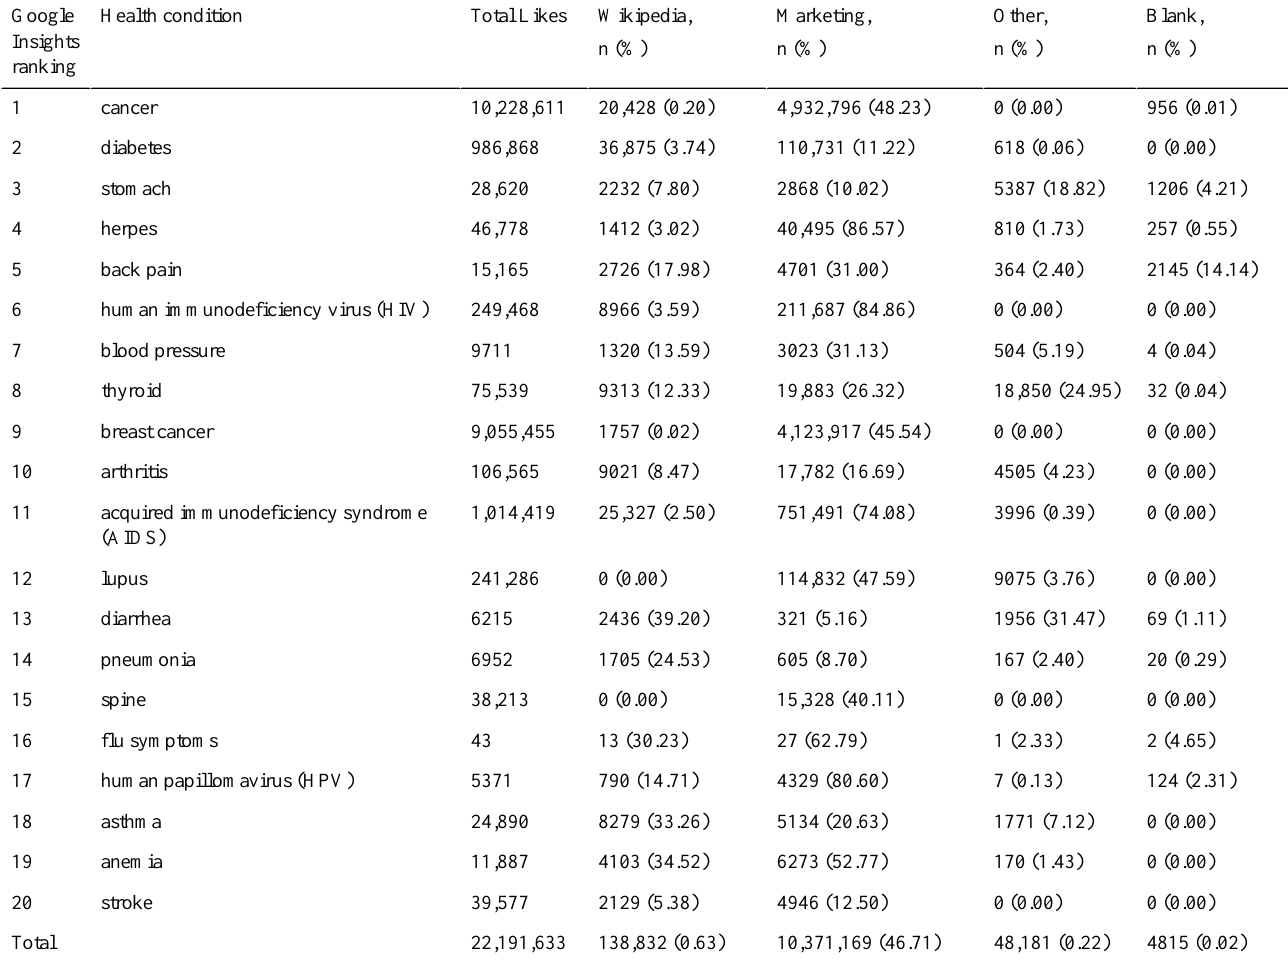
Table 8. Facebook “Likes” by health condition and content—Wikipedia, Marketing, Other, and Blank.